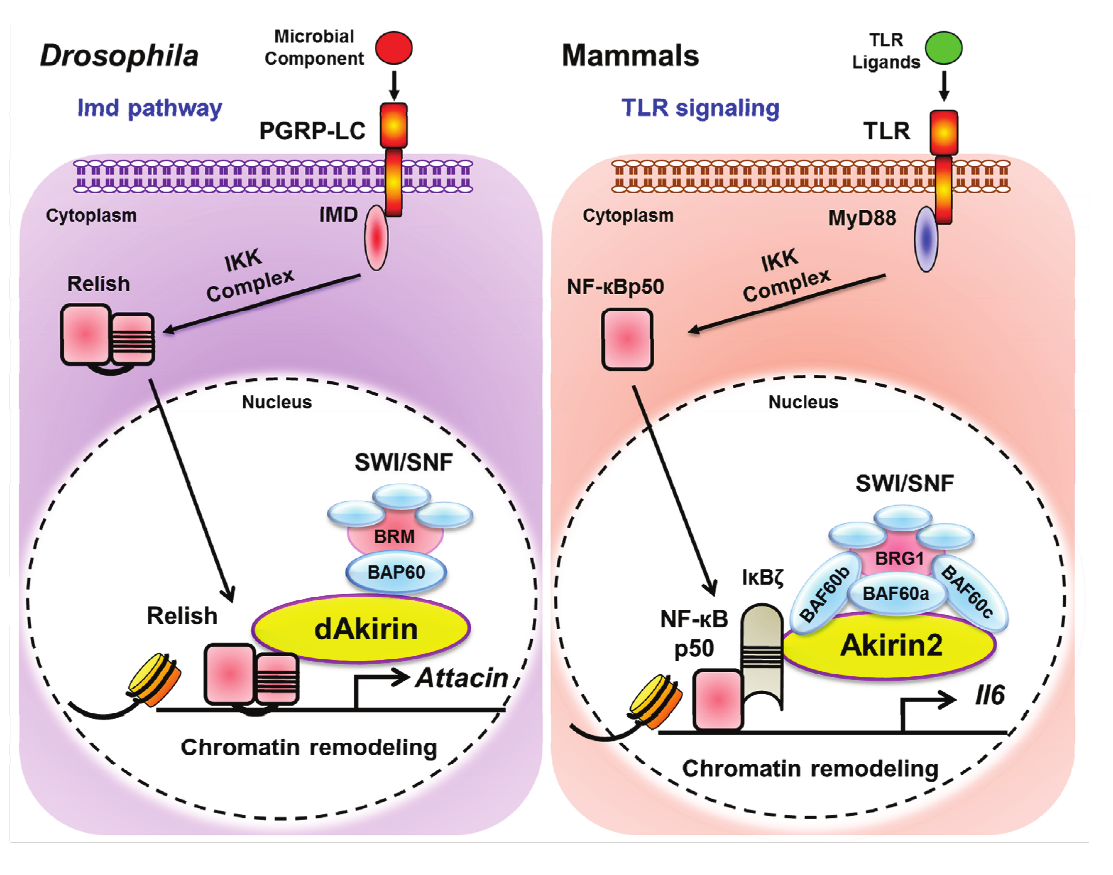
Figure 3. Evolutionary conservation of chromatin remodeling in inflammatory gene expression. (Left Panel) The Drosophila melanogaster Imd pathway. Peptidoglycan (PGN) from Gram-negative bacteria is sensed by PGRP-LC, which activate Imd. Imd recruits IKK signaling complex, which phosphorylates Relish, triggering its cleavage. The ankyrin repeats of Relish remain in the cytoplasm, and the “REL” moiety translocates to the cytoplasm to activate transcription of target genes. Akirin forms a complex with Bap60 (component of BRM complex) and facilitate the recruitment of whole complex to the promoters of its target genes. (Right Panel) The mammalian TLR signaling pathway. Activation of TLRs by their respective ligands leads to signaling that ultimately activates NF-(cid:2)B. Similar to the process of the Imd pathway, IKK complex phosphorylates an inhibitory regulator of NF-(cid:2)B, I(cid:2)B(cid:5), resulting in release of NF-(cid:2)B for translocation to the nucleus and activation of gene expression. p50 subunit of NF-(cid:2)B interacts with the pre-formed complex of I(cid:2)B - (cid:7)-Akirin2-BAF60 (component of Brg1 complex) and facilitates the recruitment of SWI/SNF complex to the promoters of its target genes for their